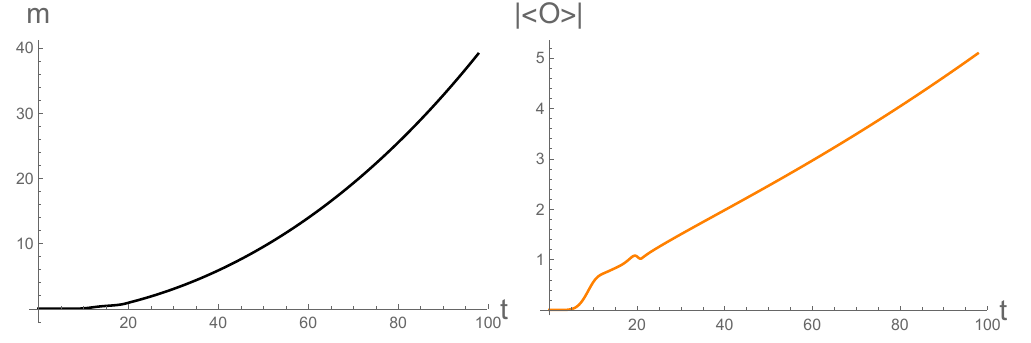
Figure 26 . Left: phase portrait of the time evolution of the SPS with (cid:26) b = 0 : 01 ; ! b = 2 : 375 when perturbed by its fundamental, unstable eigenmode with amplitude (cid:15) = 0 : 001. We start at t = 30. Each period of the source has a di(cid:11)erent color, whose wavelength increases the later it starts. Right: relative value of the imaginary part of nonlinear conductivity (cid:27) . A nonzero value indicates that the system response is partially in-phase with the driving.